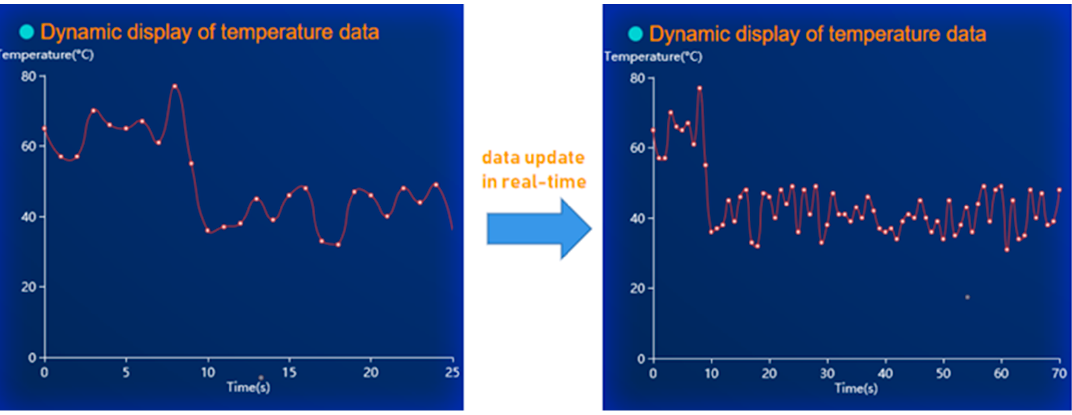
Figure 7. The temperature curve updated in real time.